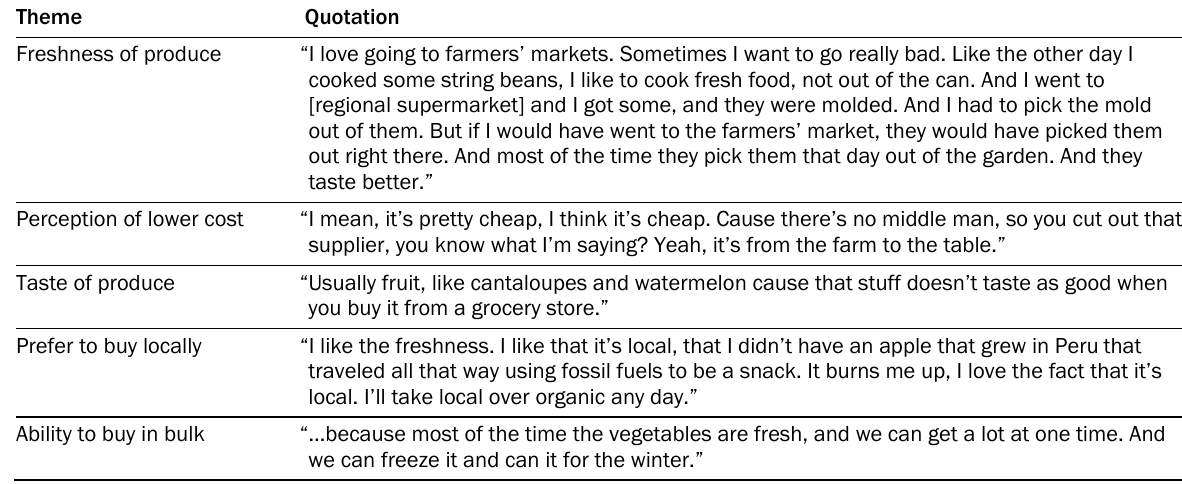
Table 2. ENC Reasons for Procuring Food from Local Food